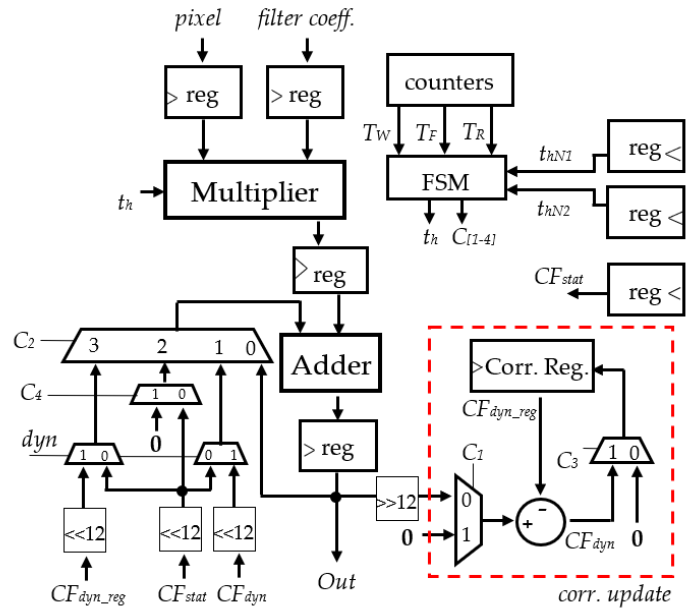
Figure 12. RTL schematics of the case study.